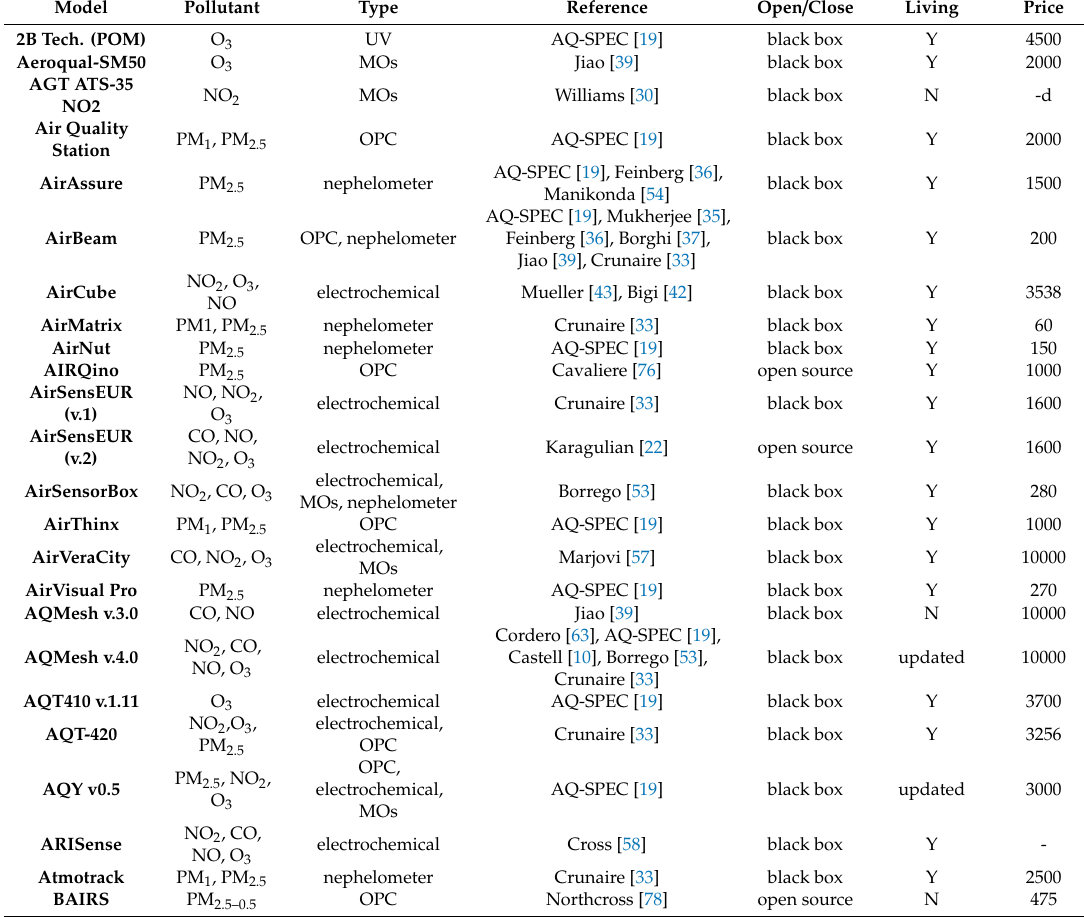
Table A3. Models of Sensor Systems by pollutant, type, openness, and